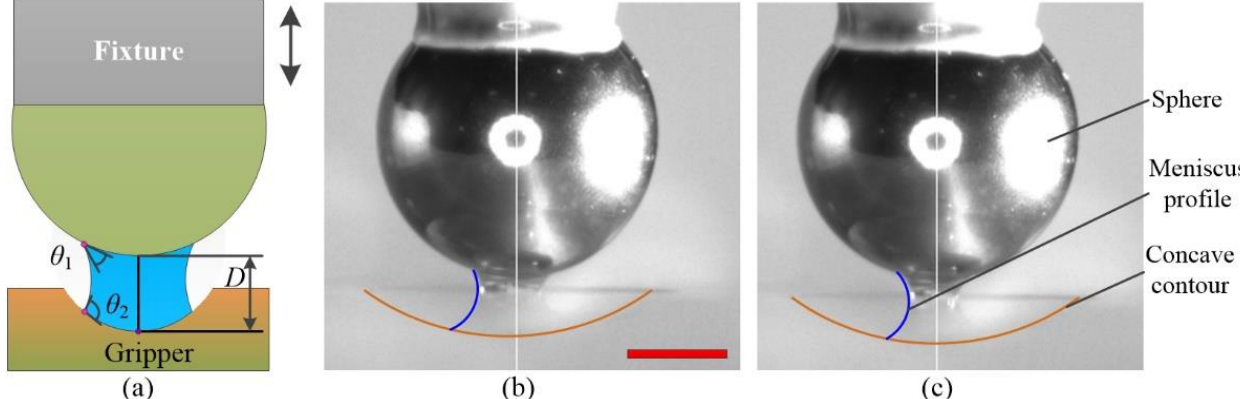
Figure 9. Processes of capillary force measurements: ( a ) geometrical representation of a stable liquid bridge, ( b ) separation distance of 0.36 mm, and ( c ) separation distance of 0.4 mm. The scale bar is 0.5 mm.